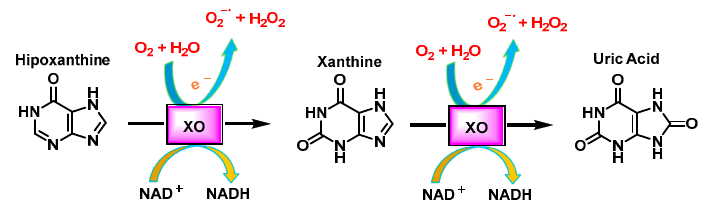
Figure 15. Reactions catalysed by xanthine oxidase.